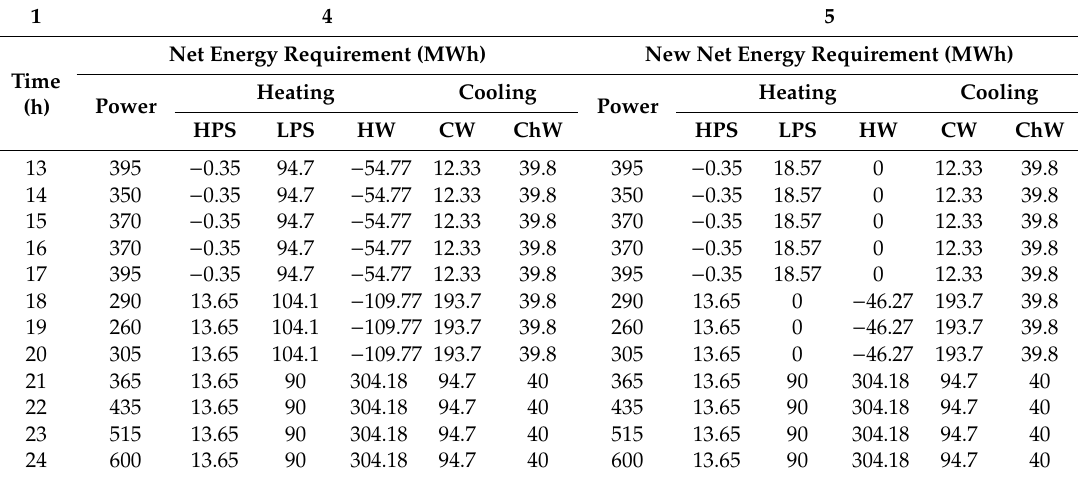
Table A4. TriGenSCA before iteration from time 13 to 24 h.